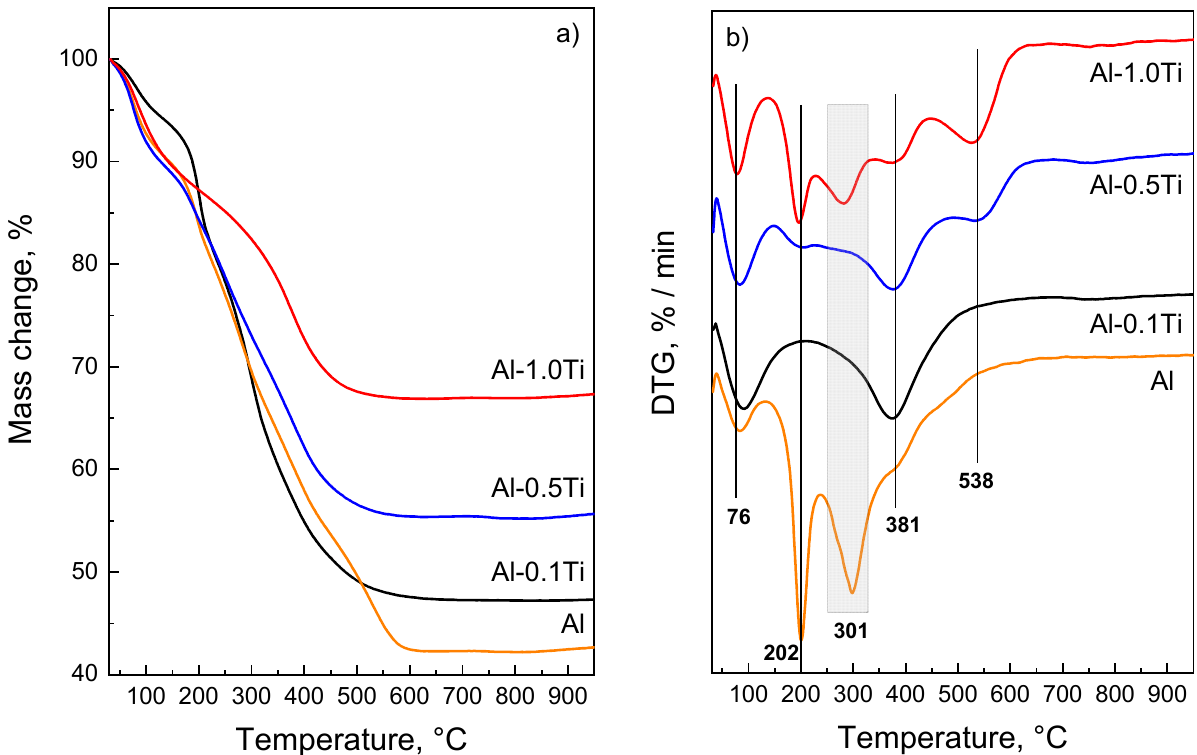
Figure 3. Thermogravimetric ( a ) and derivatographic ( b ) curves of the oxide systems under air atmosphere.